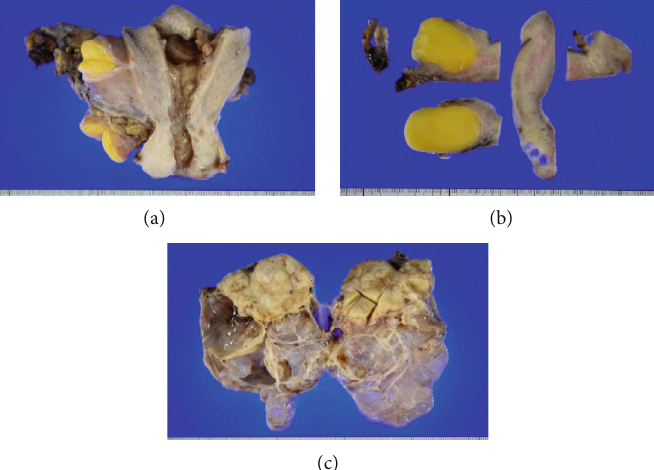
Figure 2: Macroscopic appearance of the resected uterus, left ovarian tumor: (a) macroscopic examination following hysterectomy; (b) macroscopic examination of the uterine lipoma on the cut surface; (c) macroscopic examination of the ovarian tumor following salpingo-